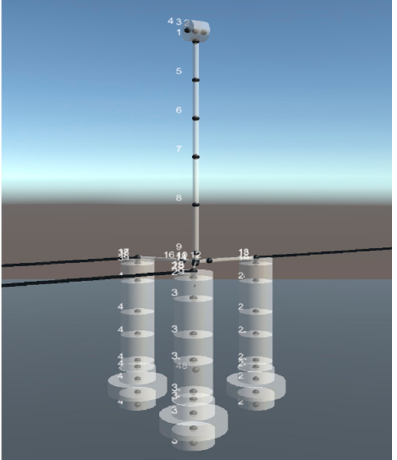
Figure 5. Mesh and nodes considered in the NK-UTWind code analysis. In the NK-UTWind code, 6DOF motions were obtained for the motion of the center of gravity. The displacement of the tower top and column bottom was evaluated by the elastic deformation using bending moment on each